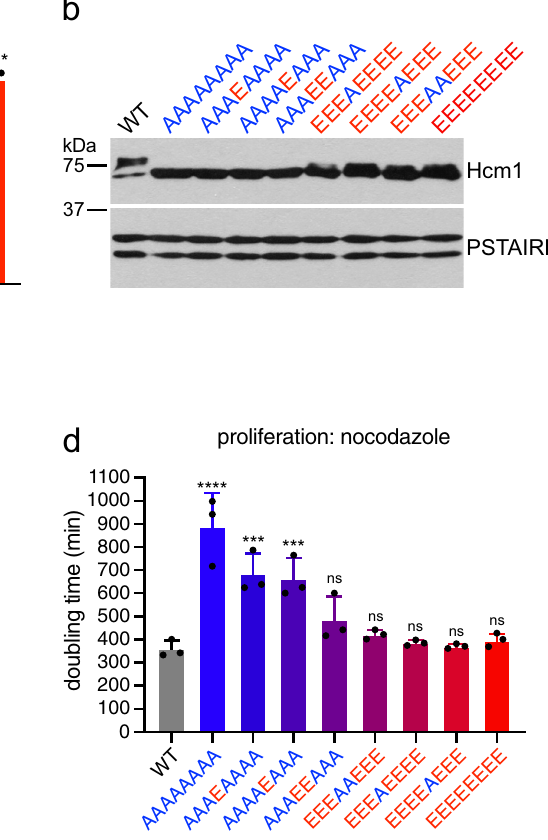
Fig. 3 | Fitness values predict the transcriptional activation and cell cycle regulatory functions of Hcm1. a Transcriptional activation assay of LexA-DBD fusedtotheHcm1TADwiththeindicatedphosphositemutations,andWTorempty vector (EV) controls. Black represents EV, gray represents WT, color gradient from blue ( hcm1-8A ) to red ( hcm1-8E ) corresponds to increasing number of phospho- mimeticmutations.Errorbarsrepresentstandarddeviation,shownisanaverageof n =3 replicates. Signi fi cance was tested using repeated measures one-way ANOVA with Dunnett ’ s multiple comparisons test. Asterisks indicate signi fi cantly different fromWT,**** P <0.0001,* P <0.05,ns=non-signi fi cant.EV,AAAAAAAA,AAAEAAAA, AAAAEAAA P <0.0001; AAAEEAAA P =0.9922; EEEAAEEE P =0.0484; EEEAEEEE, EEEEAEEE, EEEEEEEE, P <0.0001. Supplementary Fig. 4a con fi rms that the fusion proteins are expressed at similar levels. b Western blot of the indicated Hcm1